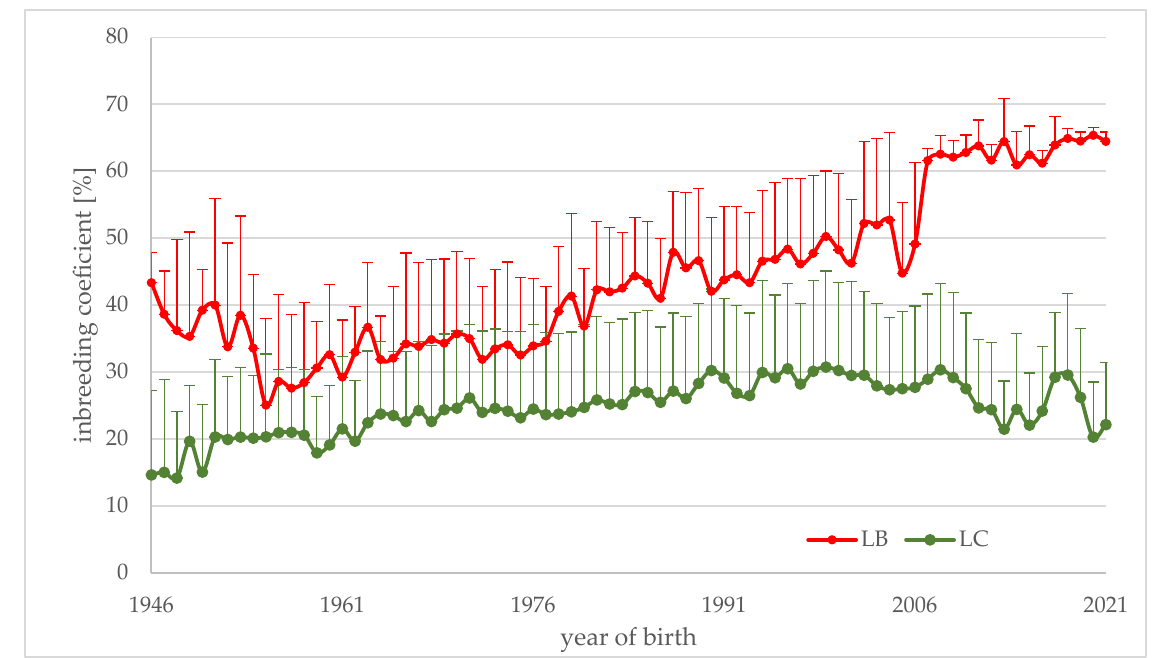
Figure 1. The mean inbreeding coefficient with standard deviation bar for animals of LB and LC lines with full known pedigree born in years 1946–2021.